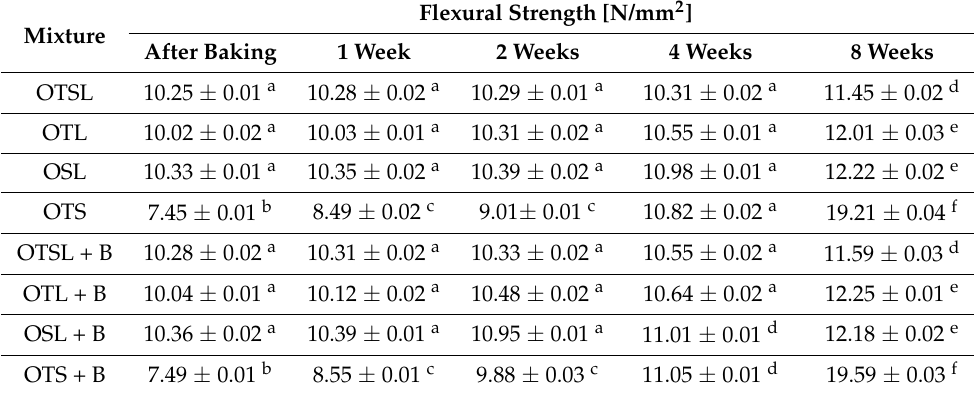
Table 2. The flexural strength of the disposable